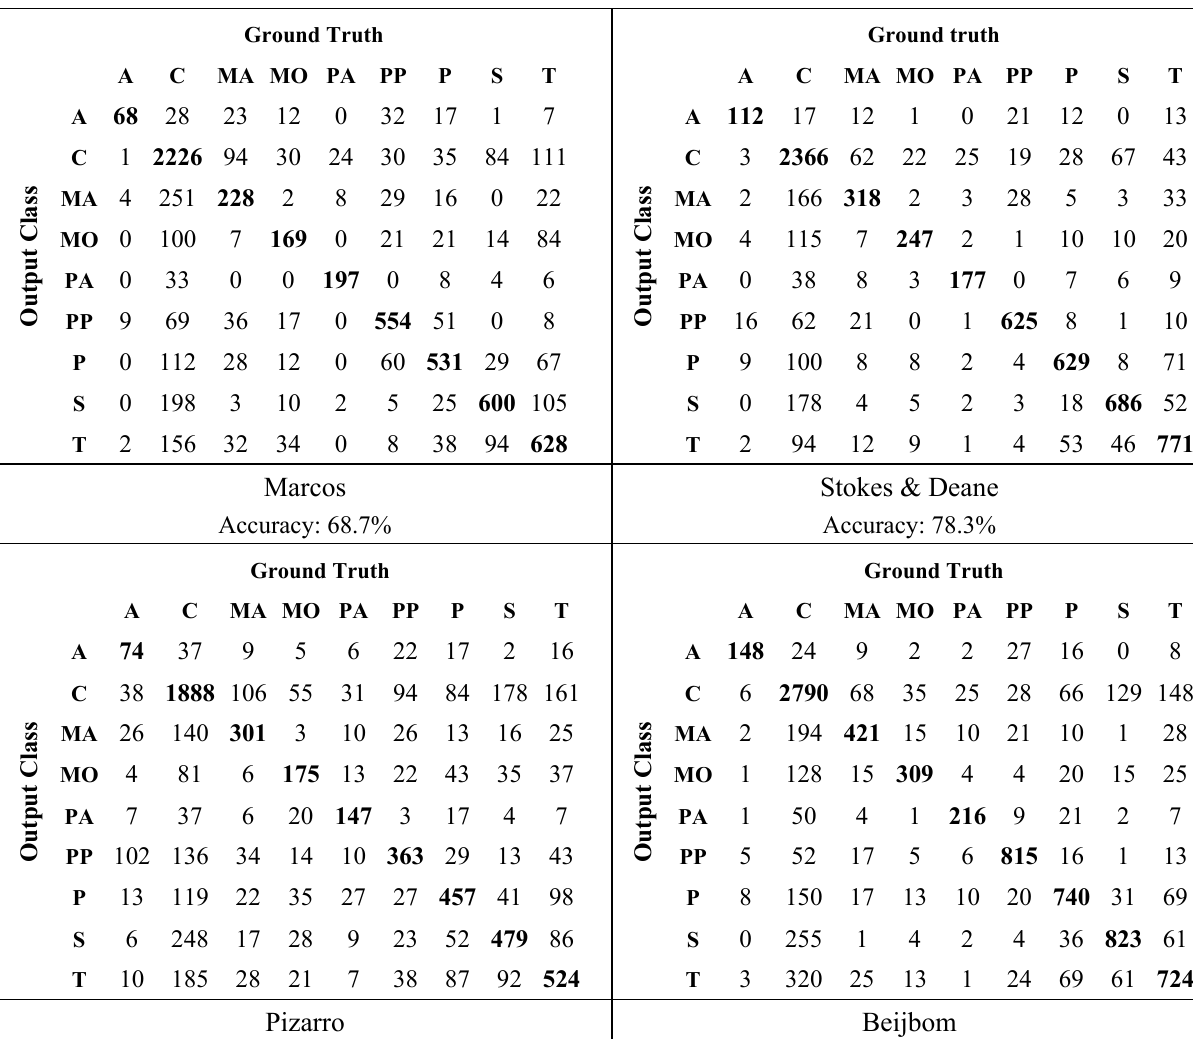
Table 10. The error matrices of the tested other methods as applied to the MLC 2008